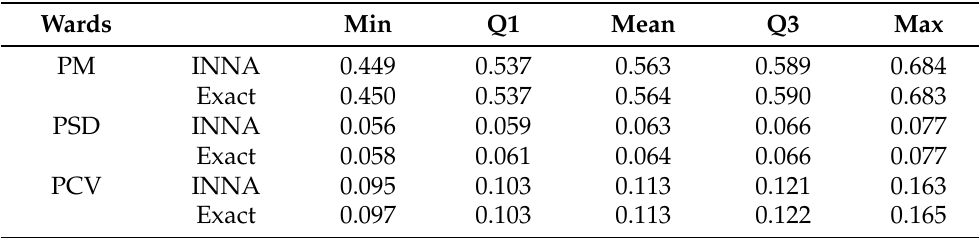
Table 5. Comparison of posterior inference about the finite population proportions using five-number summaries at the ward level.